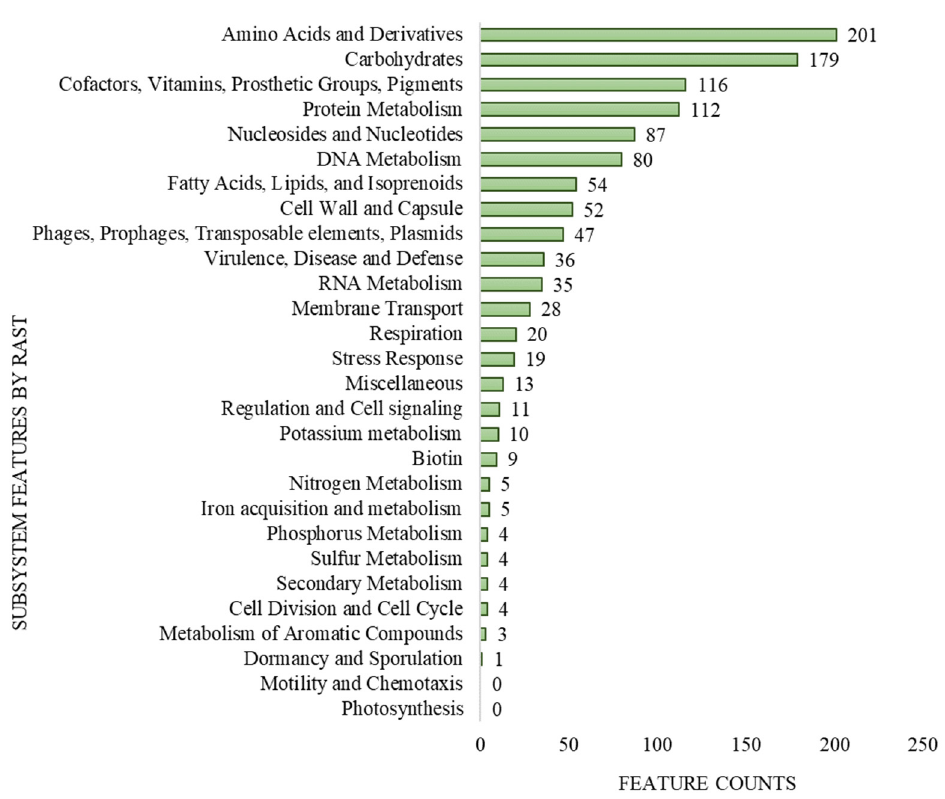
Figure 1. Subsystem coverage and distribution of L. lactis LL16 genome by Rapid Annotation using Subsystem Technology (RAST v.2.0) genome server.